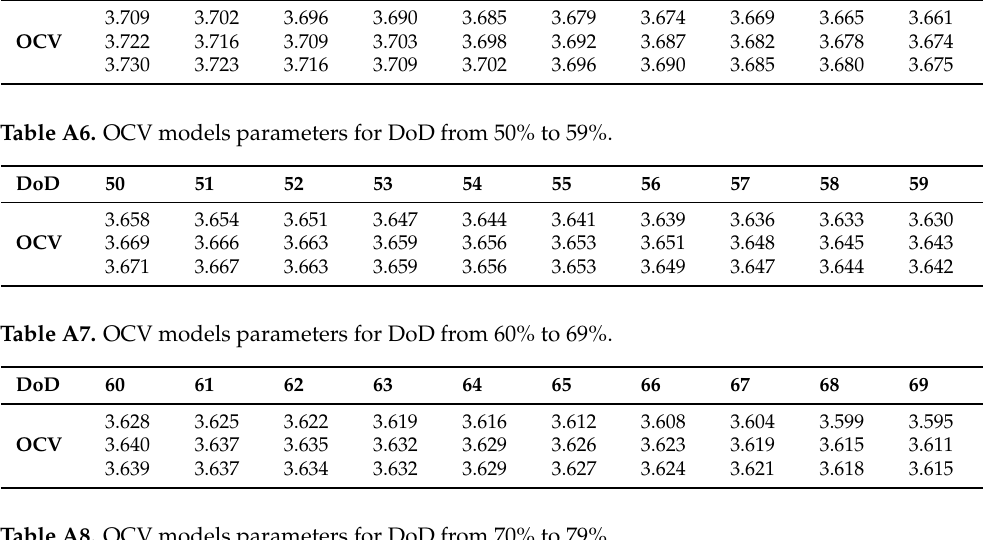
Table A8. OCV models parameters for DoD from 70% to 79%.